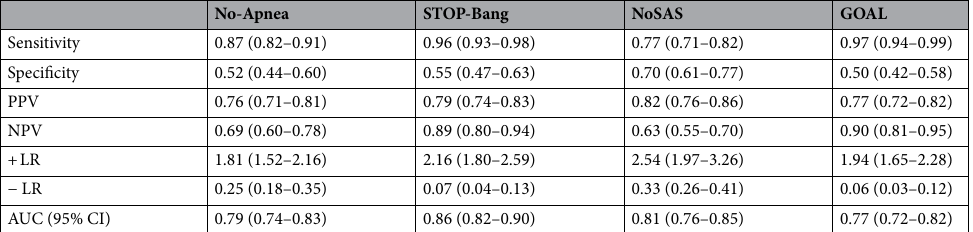
Table 3. Predictive parameters of the four screening tools at AHI ≥ 15 events/h. AHI apnea hypopnea index, PPV positive predictive value, NPV negative predictive value, + LR positive likelihood ratio, − LR negative likelihood ratio, AUC area under the curve. Data are presented as values (95% confidence intervals).